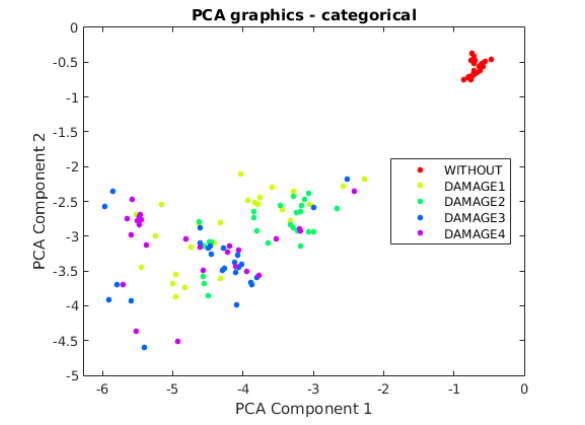
Figure 22. First principal component versus second principal component in the aluminum rectangular profile described in Section 4.1.